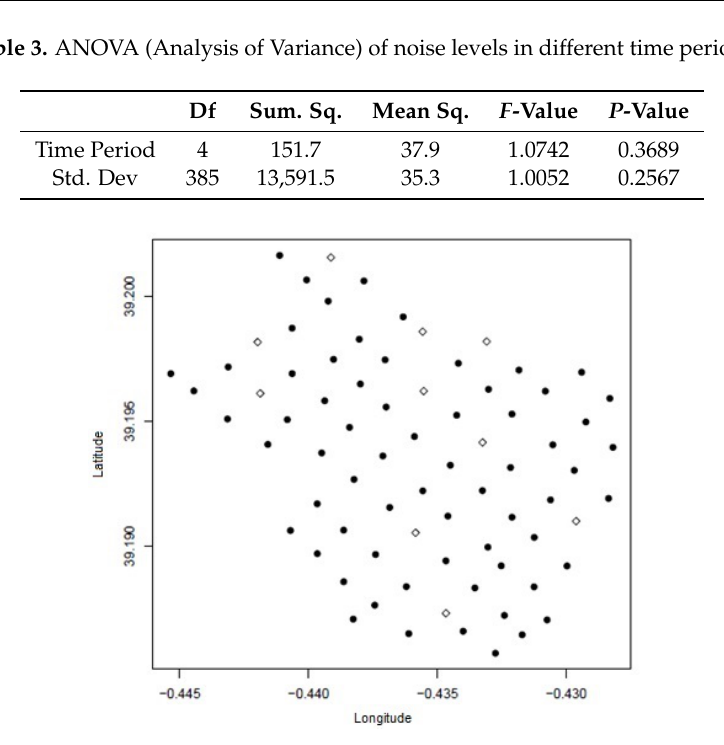
Figure 5. Modelling set ( black dots); and validation set ( white